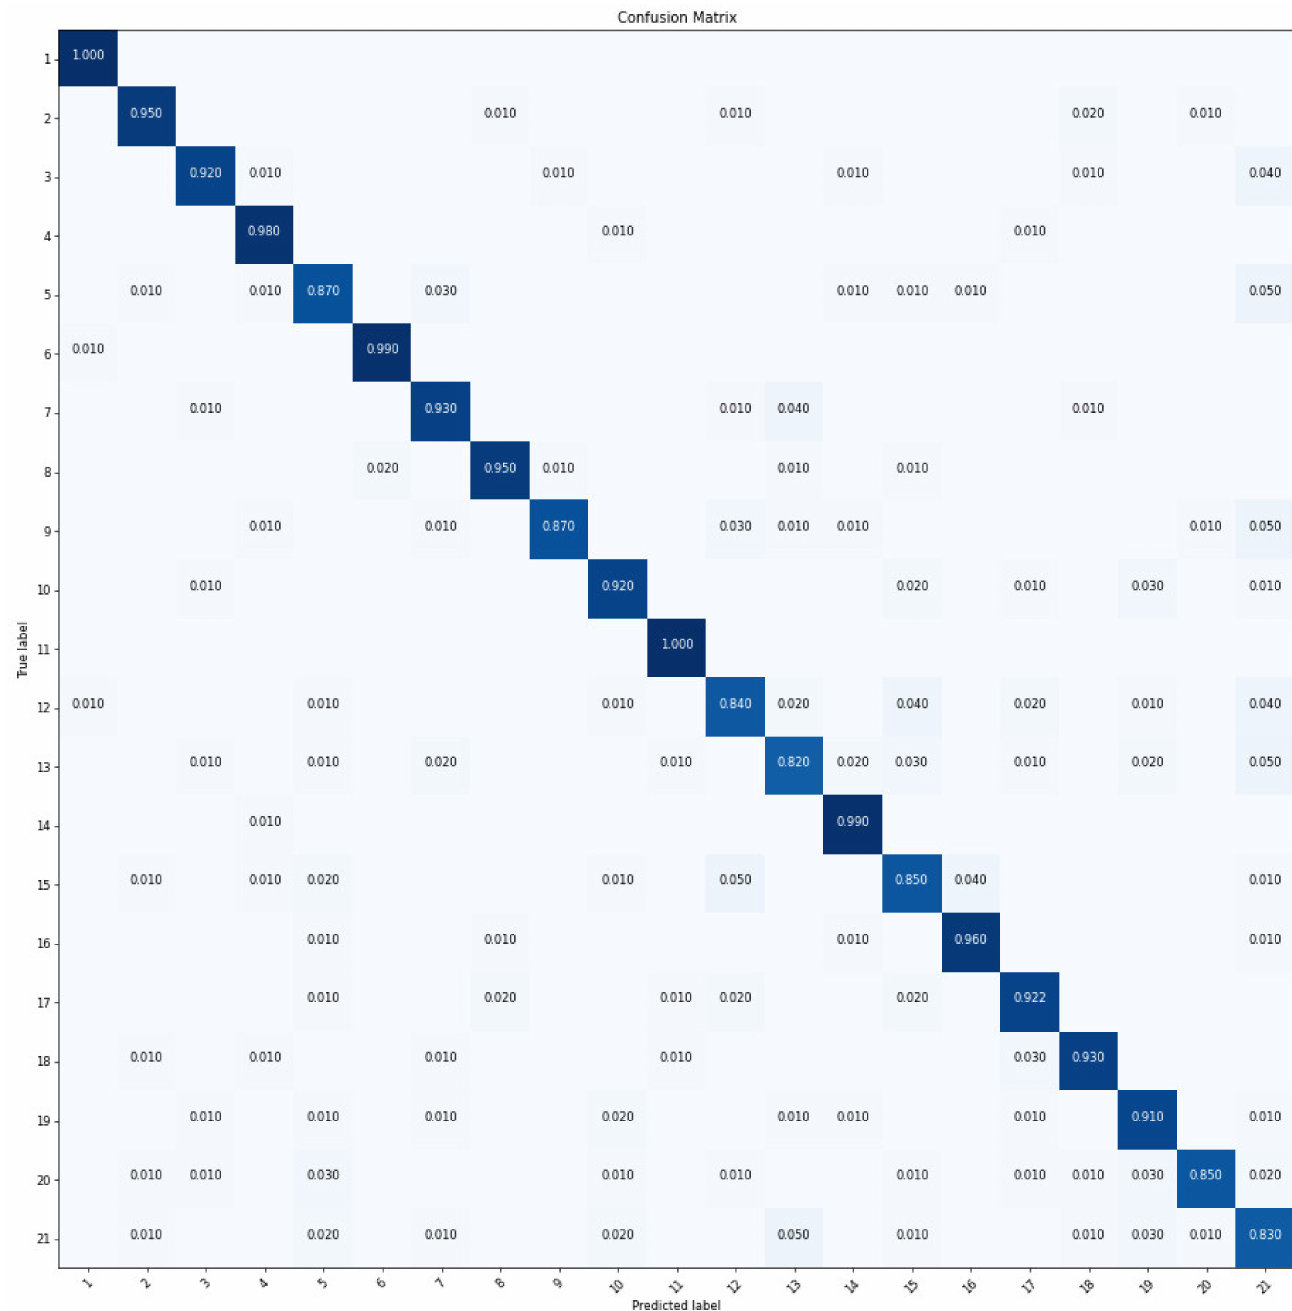
Figure 12. CM of MGCNN-C4 obtained with the UC-Merced